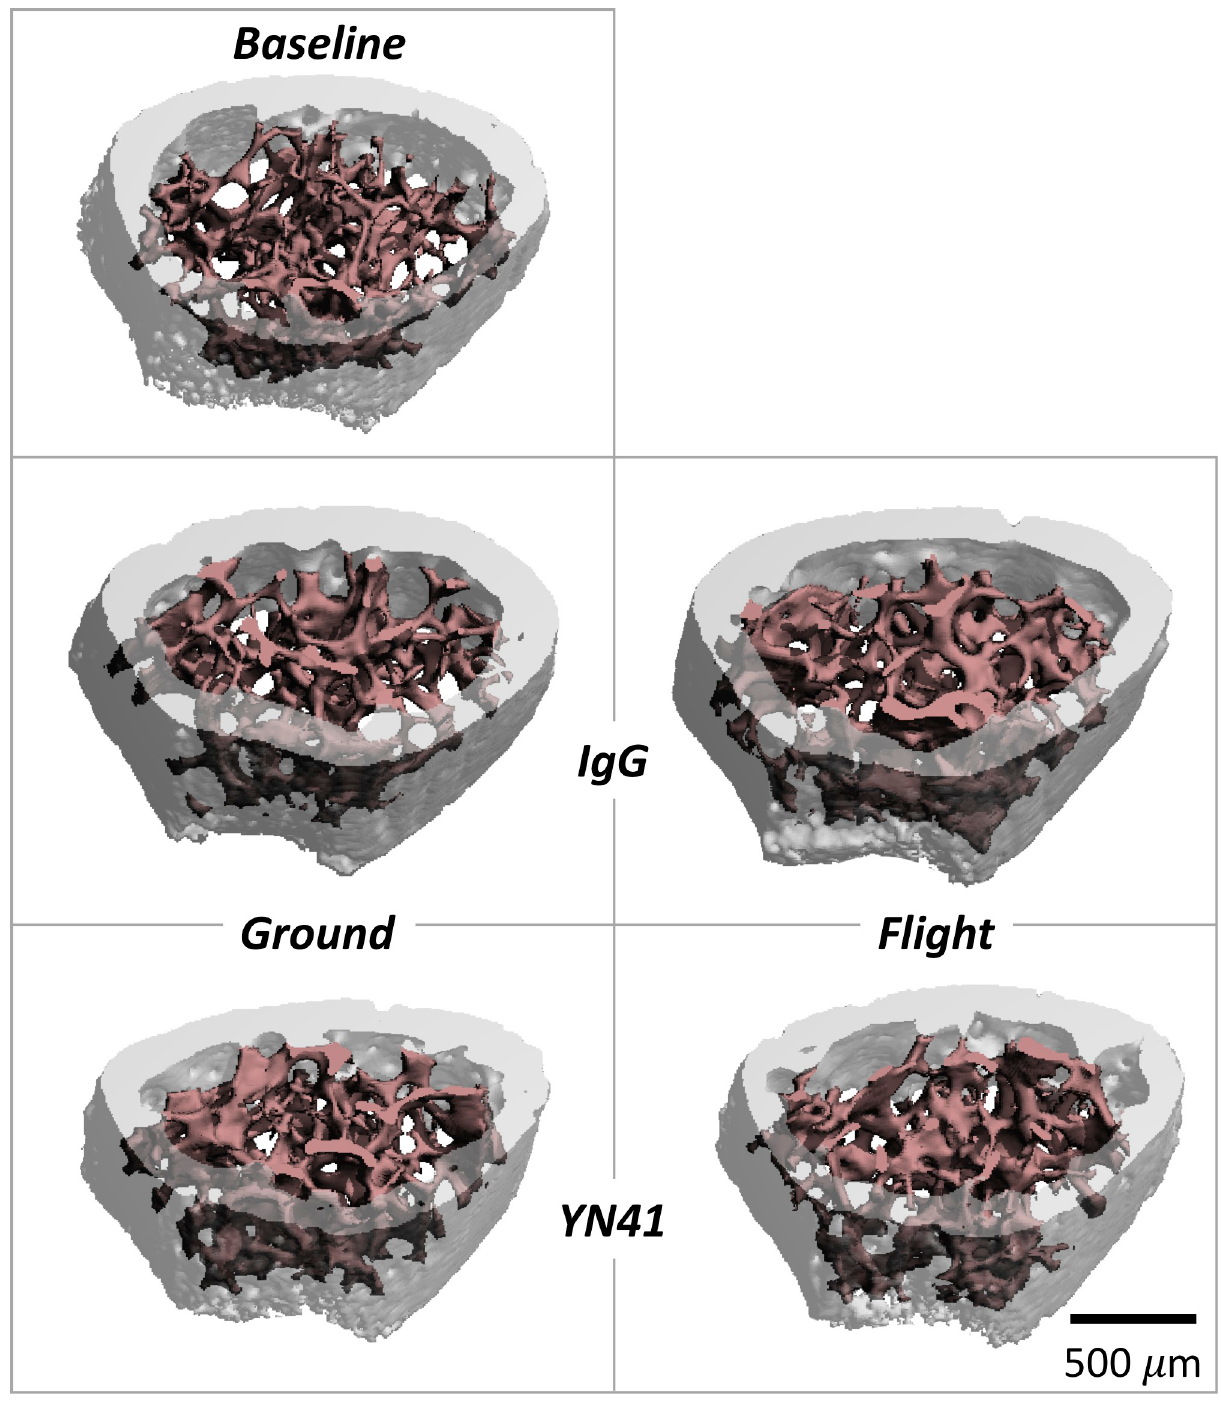
Fig 6. Representative micro-computed tomography images from the distal femur from baselines as well as ground and flight mice treated with either IgG or YN41. While visual differences between groups are subtle, the microarchitecture of both trabecular and cortical compartments significantly improved with skeletal maturation when comparing baseline to ground controls (IgG), and both bone compartments were significantly diminished with microgravity exposure (comparing IgG ground to flight groups) but were unaffected by myostatin inhibition.